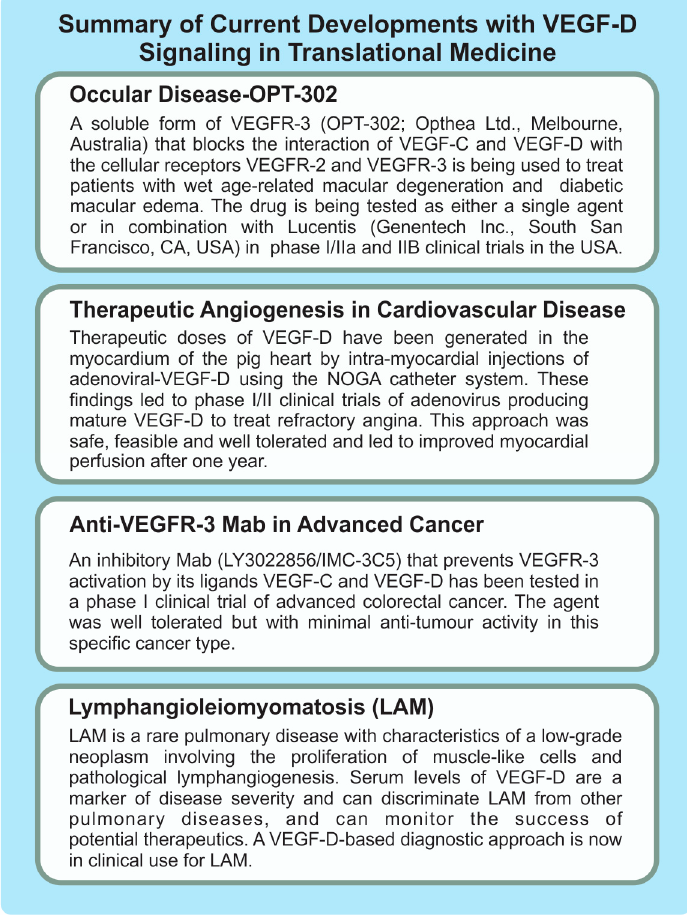
Figure 3. Summary of current and potential therapeutic and diagnostic applications of the VEGF-D signaling pathway in human disease. The diagram includes information on recent clinical trials and the use of diagnostic tests. Further information and references are included in the text of this article.